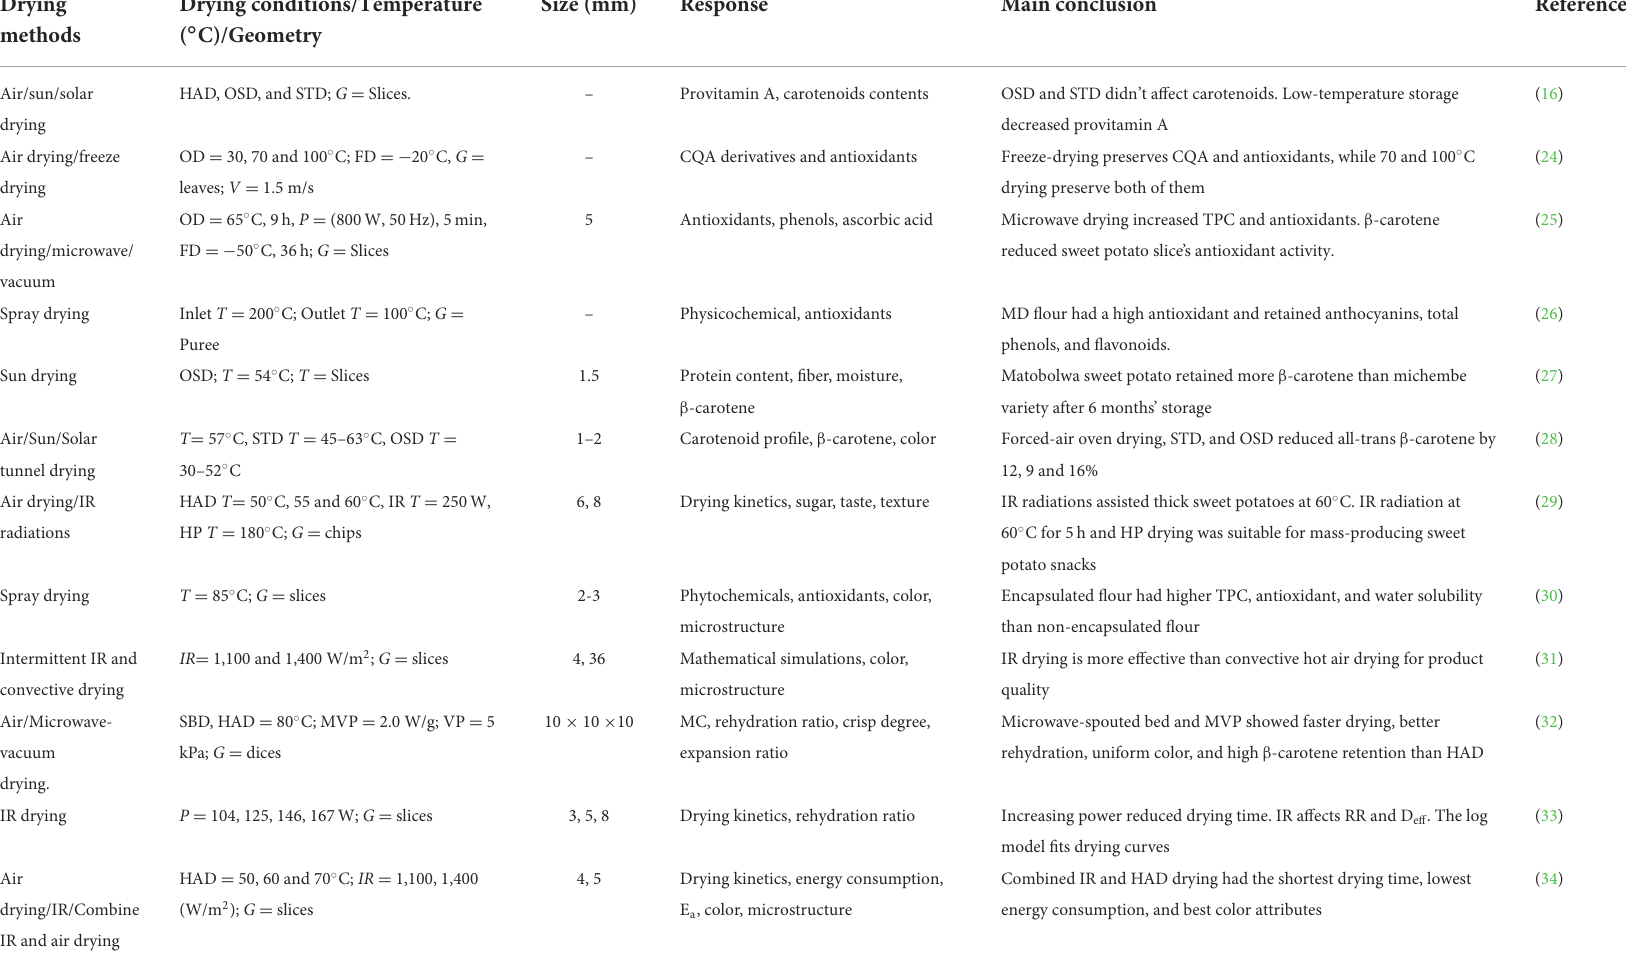
TABLE 2 Hot-air drying combined with other drying methods was conducted to dry sweet